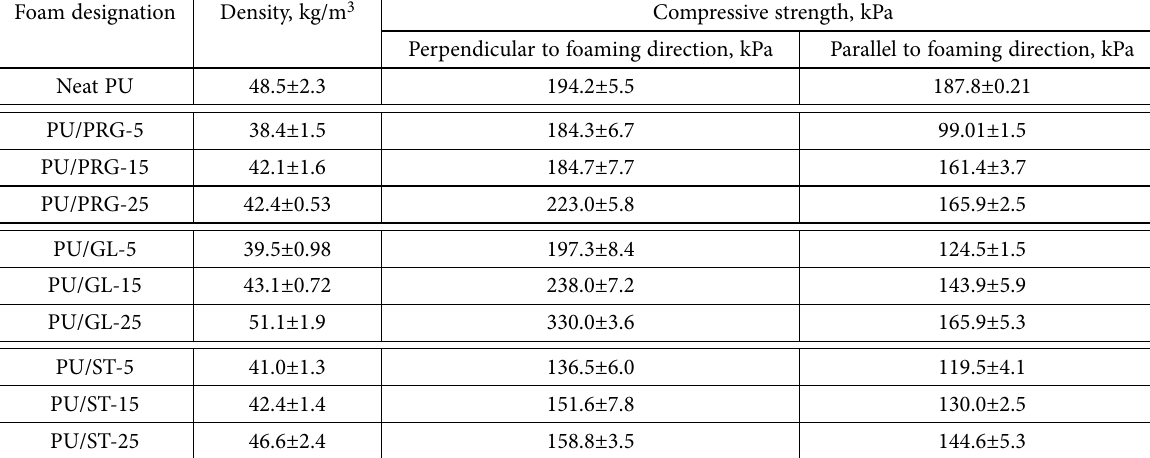
Table 2. Strength properties and density of extended PU